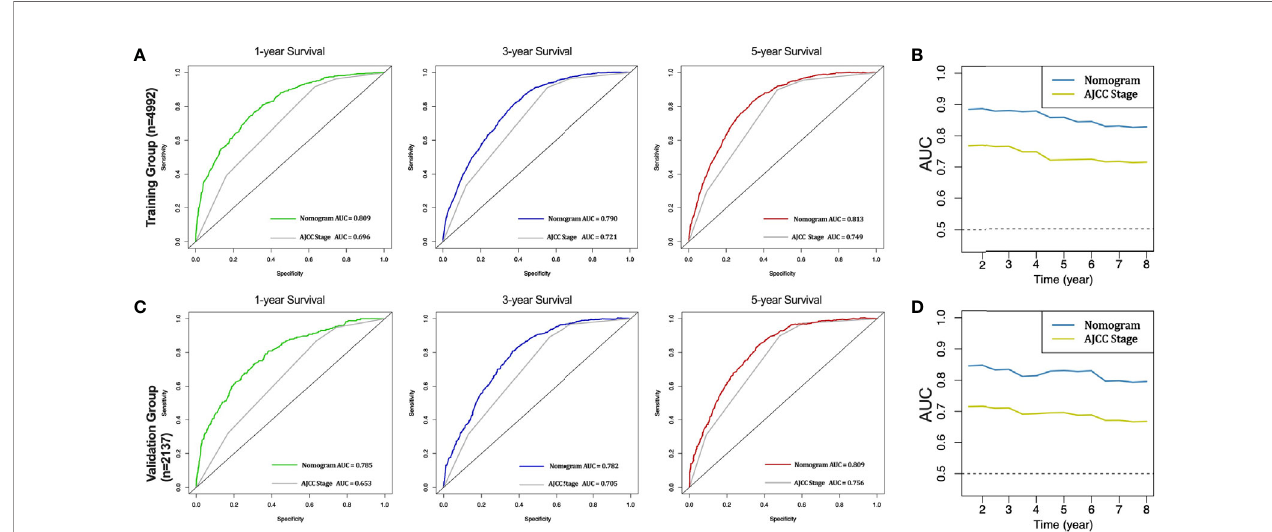
FIGURE 4 | AUC curves of the nomogram and AJCC stage in prediction of prognosis in the training and validation cohorts. AUC curves of the nomogram and AJCC stage in prediction of prognosis at 1-, 3- and 5-year point in the training cohort (A) . Time dependent AUC curves of the nomogram and AJCC stage from 0.5 year to 8 year in the training cohort (B) . AUC curves of the nomogram and AJCC stage in prediction of prognosis at 1-, 3- and 5-year point in the validation cohort (C) . Time dependent AUC curves of the nomogram and AJCC stage from 0.5 year to 8 year in the validation cohort (D) .